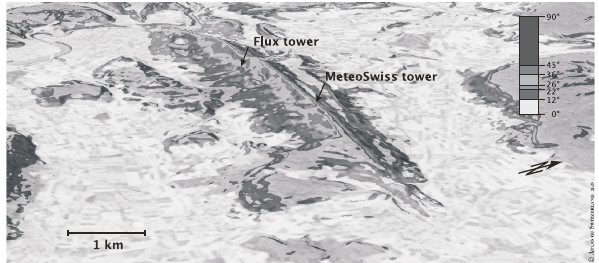
Fig. 1. The L¨ageren mountain ridge. Colours indicate the slope angle of the respective area. The L¨ageren flux tower and the Me- teoSwiss tower are marked. (Reproduced with authorisation of swisstopo